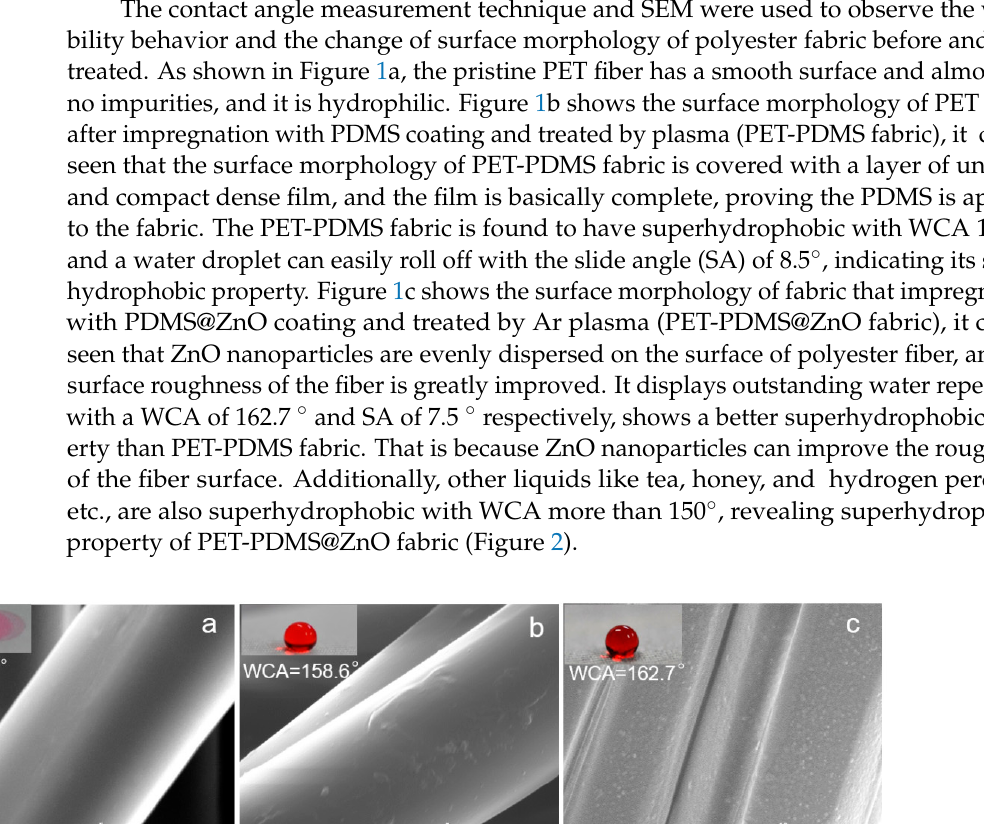
Figure 2. Optical image of PET-PDMS@ZnO fabric consisting of various droplets. To confirm the existence of silicon and zinc and observe their distribution on polyes- ter fiber, energy dispersive spectrometry (EDX) was used, and the results are shown in Figure 1d–f. As shown in Figure 1d, the rough coating layer is composed of elements of carbon, oxygen, silicon, and zinc. Among them, silicon and zinc are accounting for 18.13% and 5.08% respectively. Silicon was derived from PDMS, and zinc was from ZnO. Figure 1e,f show the elemental mapping of silicon and zinc on the fabric surface. It can be seen that the distribution of silicon and zinc is uniform and is consistent with the fiber trend, and there is no obvious accumulation and blank load. The result demonstrates that the PDMS@ZnO layer is uniformly covered on the fiber. To confirm the presence of a functional group, FTIR was employed and the results are shown Figure 3. Compared with the pristine sample, some characteristic peaks of the